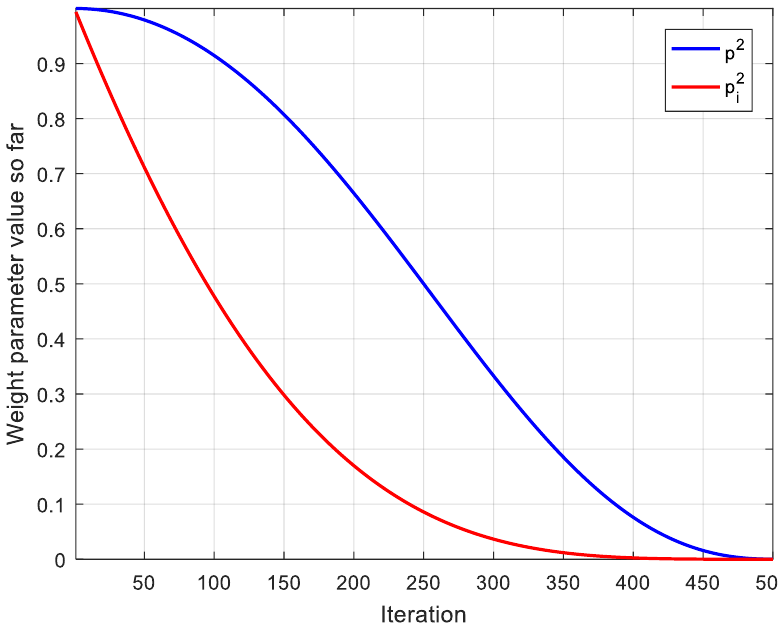
Figure 5. Comparison of the weight coefficient p before and after the improvement.